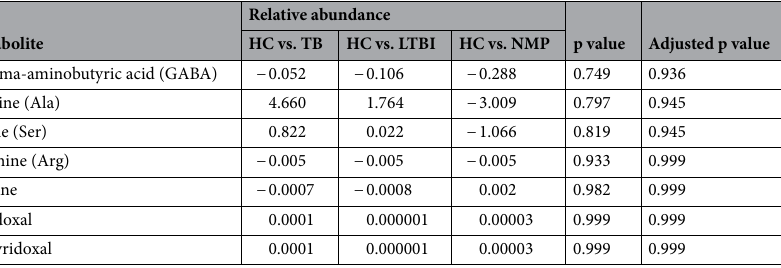
Table 3. Relative abundance of individual metabolites in M.tb -stimulated whole blood QFT cultures. HC M.tb-uninfected healthy controls, LTBI latently M.tb-infected individuals, NMP patients with nonmycobacterial pneumonia, TB active tuberculosis patients.